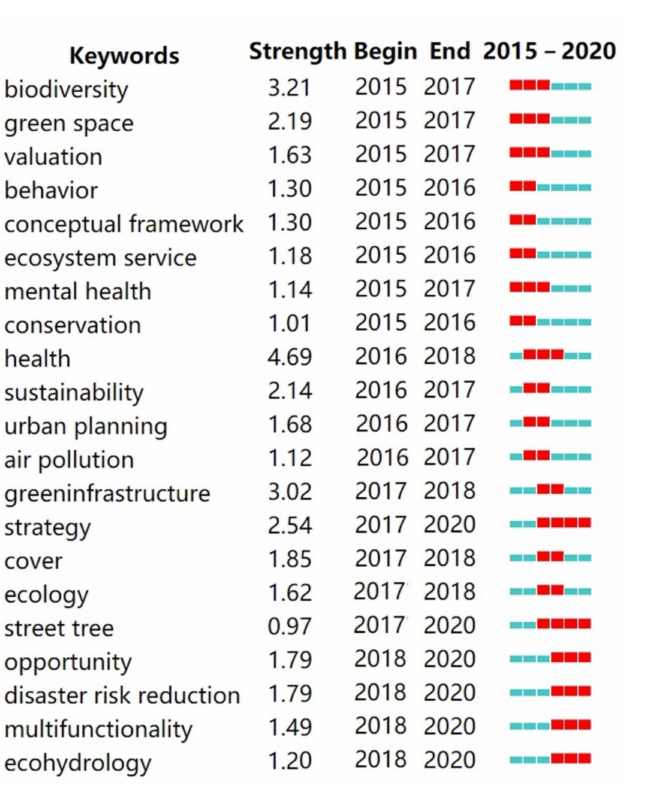
Figure 4. The 20 most common keywords with the strongest citation bursts since 2015. The short red lines represent the time period of burst